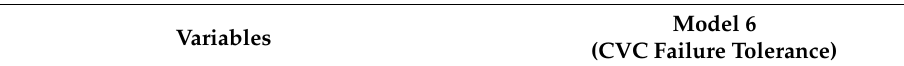
Panel B: The Difference in Failure Tolerance between SCVC and PCVC (Regression